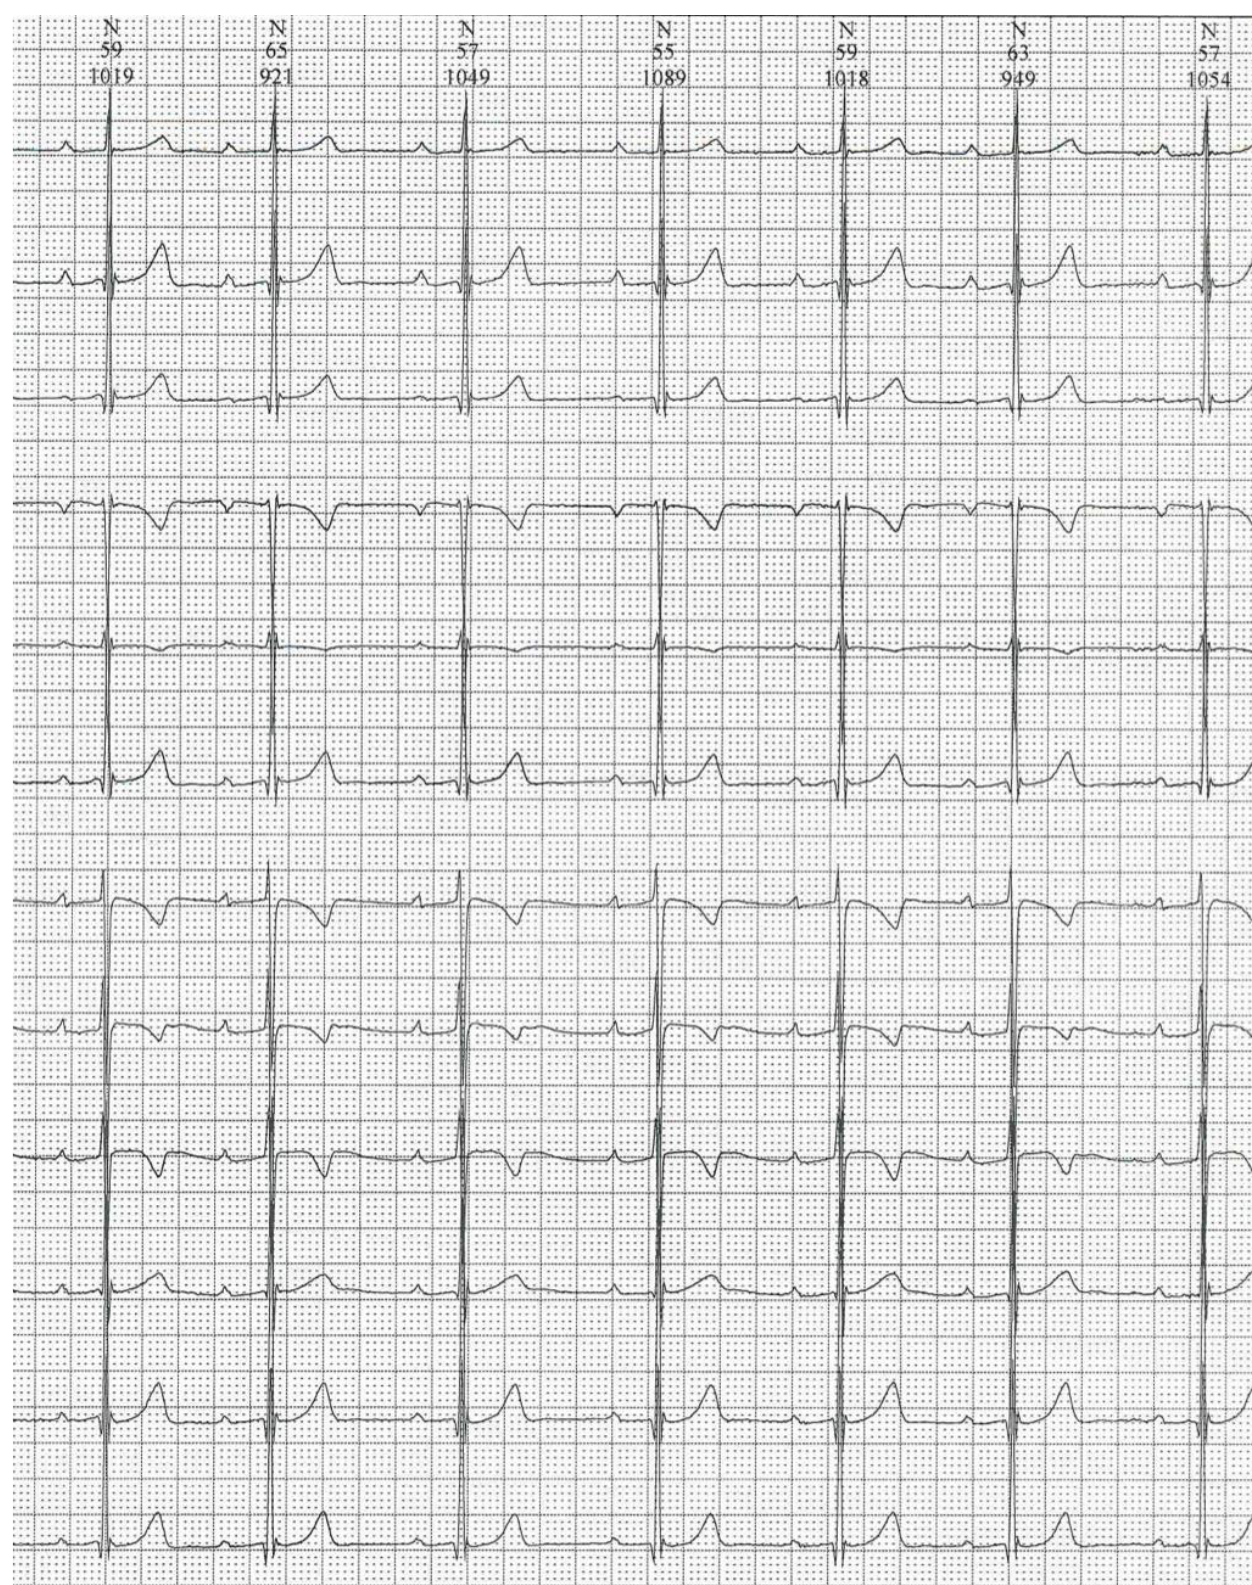
Figure 4. A 24h Holter monitoring (9 years) showing a I-degree atrio-ventricular block.